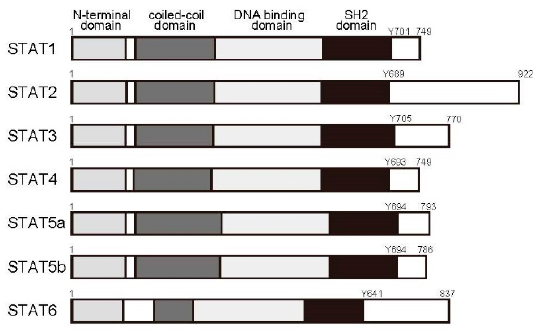
Figure 2. STAT protein structure. STAT proteins possess conserved domains, such as the N-terminal oligomerization domain (NTD), coiled-coil domain (CC), DNA-binding domain (DNBD), SH2 domain (SH2), and transactivation domain (TAD). Phosphorylation of tyrosine at the C-terminus is essential for STAT activation. STAT